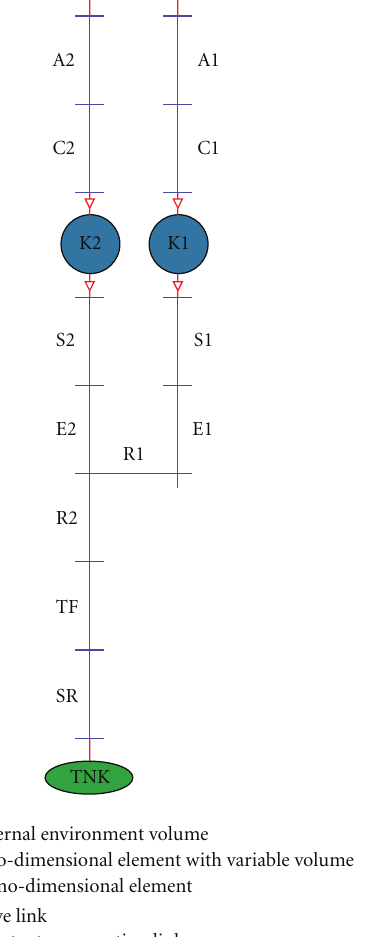
Figure 4: Geometric layout of the